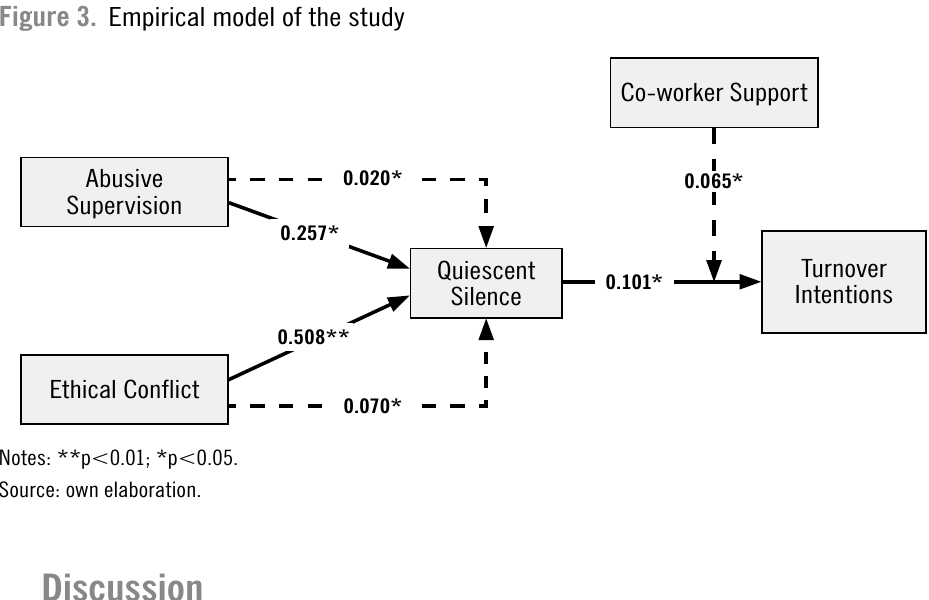
Figure 3. Empirical model of the